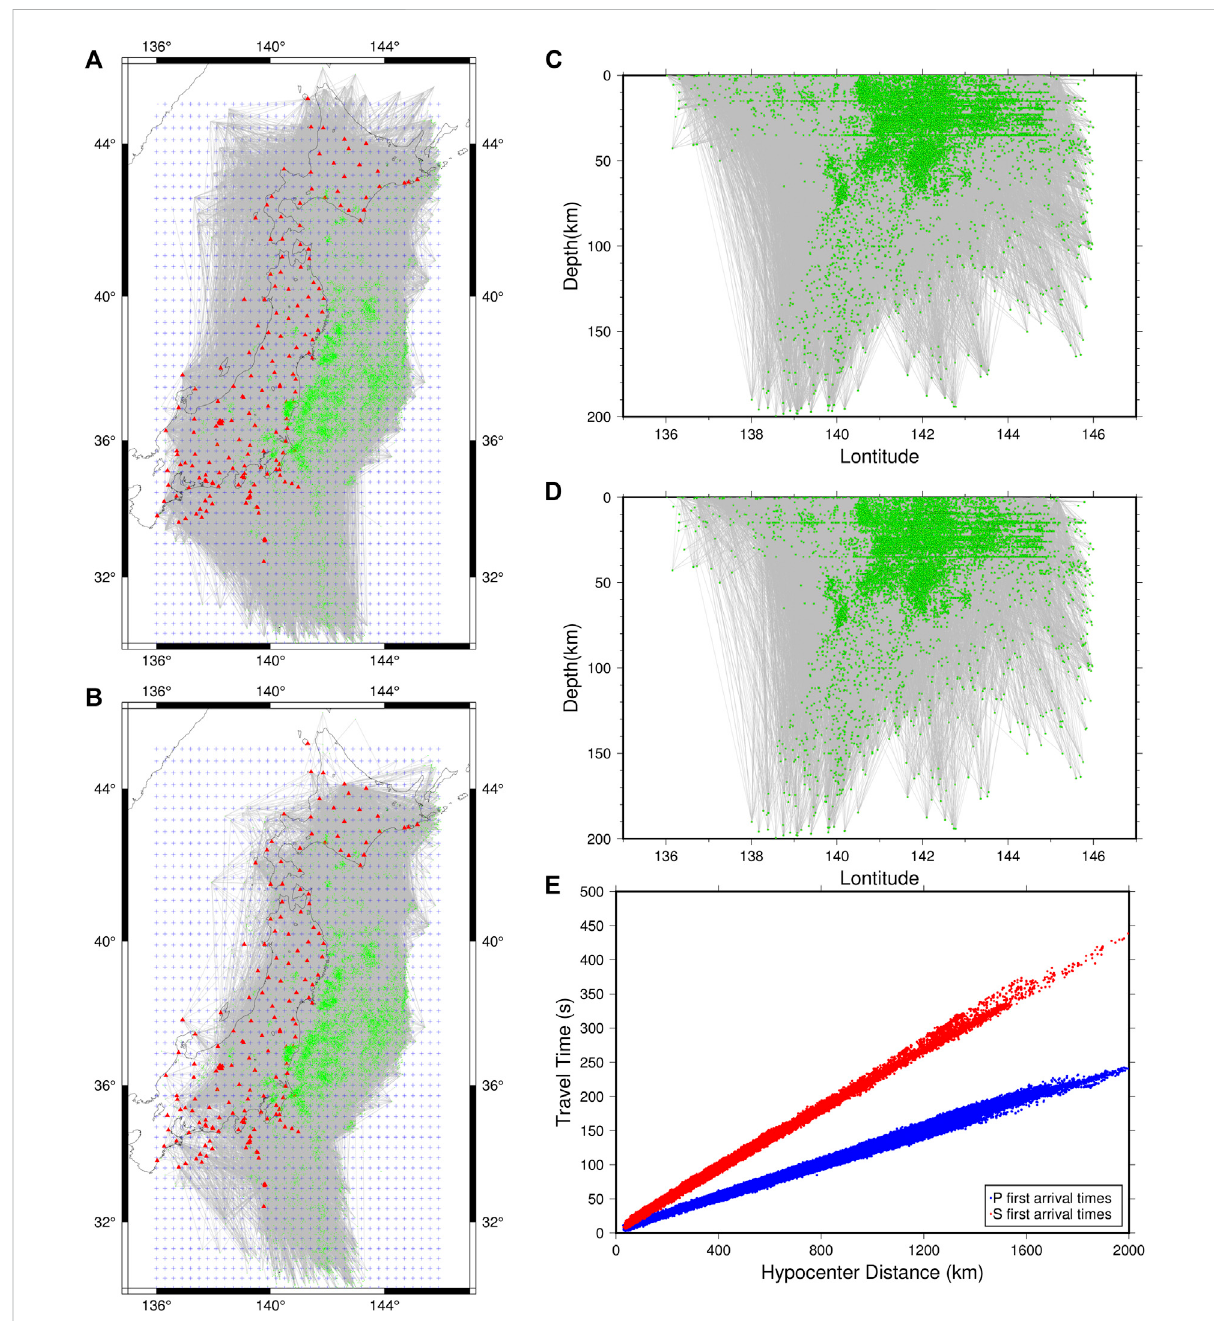
FIGURE 3 Seismic ray paths of P-wave (A) and S-wave (B) in the studied. Red triangles indicate seismic stations, green solid dots indicate earthquake locations,and bluecrosses indicate inversiongrid points. Seismicray paths of P-wave (C) and S-wave (D) vertical projection; (E) Travel time distance curves of P and S